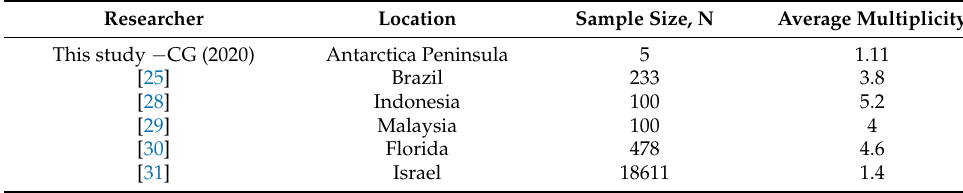
Table A4. The distribution of − CG flashes with different number of strokes.